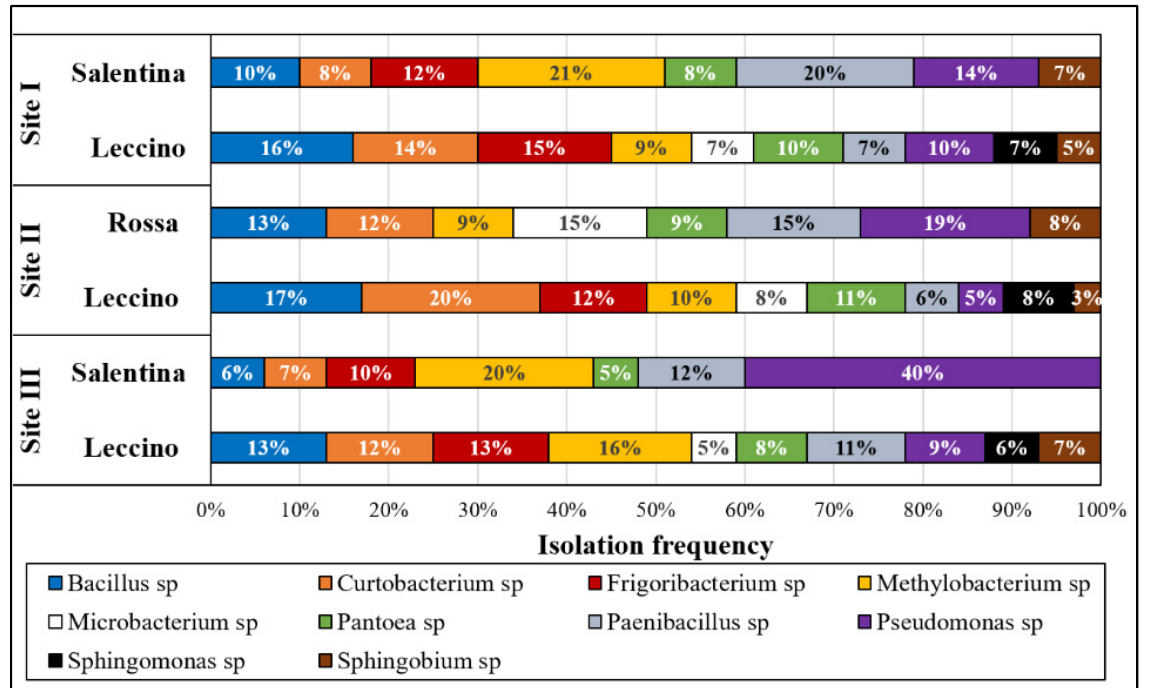
Figure 4. Relative frequency of identified endophytic bacteria colonizing olive varieties in different sampling sites.